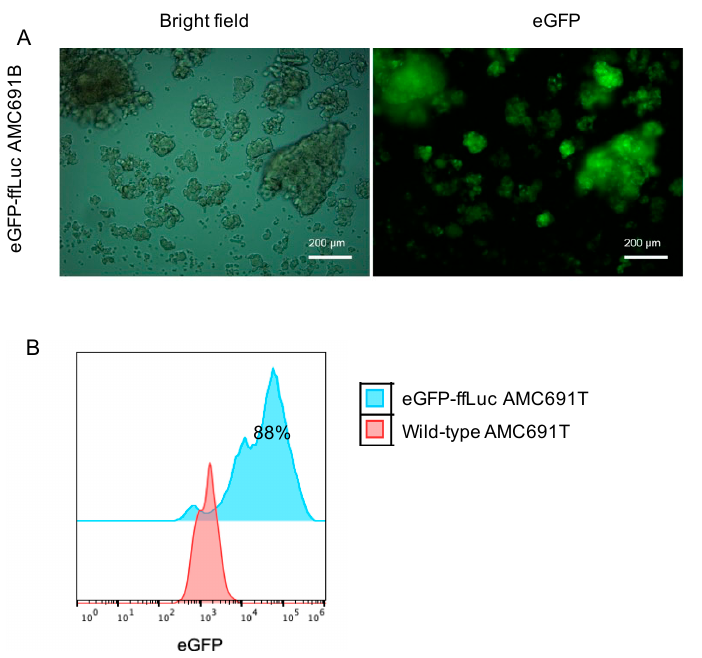
Figure 2. Patient-derived neuroblastoma organoids were examined for GFP expression 96 h after lentiviral transduction. ( A ) Fluorescence microscopy of patient derived neuroblastoma organoid AMC691B 96 h after infection after lentiviral transduction showing bright field ( left ) and fluores- cence ( right ) images. ( B ) Flow cytometry analysis of one patient derived neuroblastoma organoid (AMC691T) after lentiviral transduction. Proportions of AMC691T.